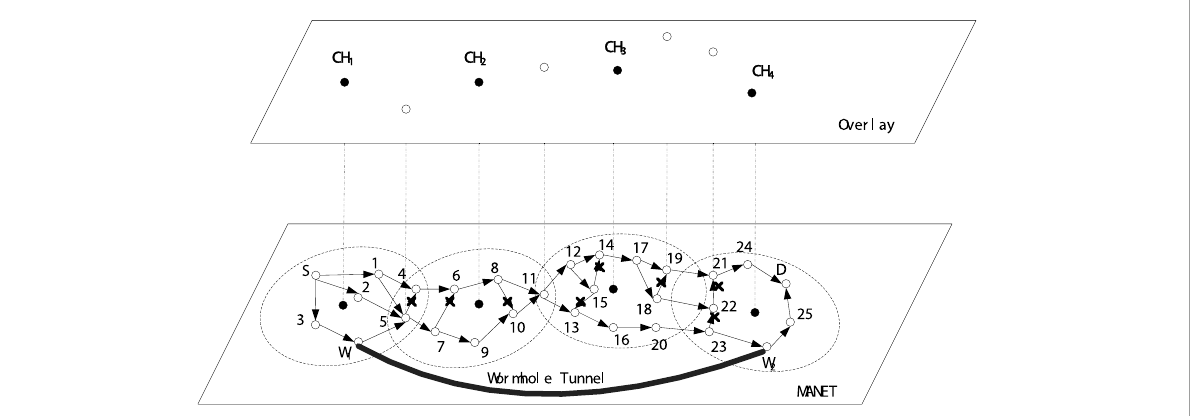
FIGURE 6 Routing request process.